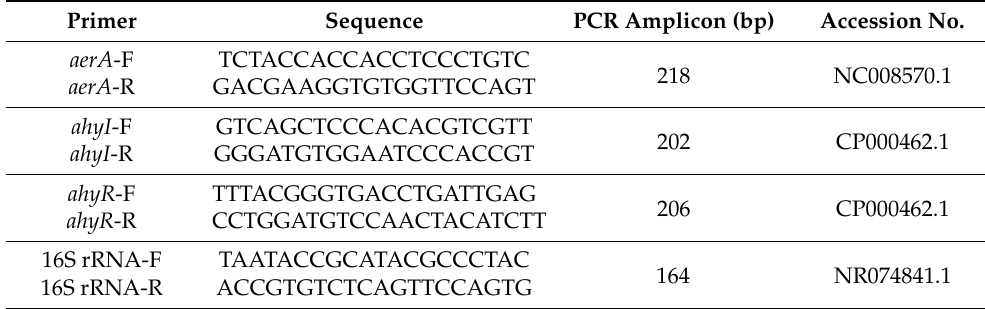
Table 1. Primer pairs used in qPCR